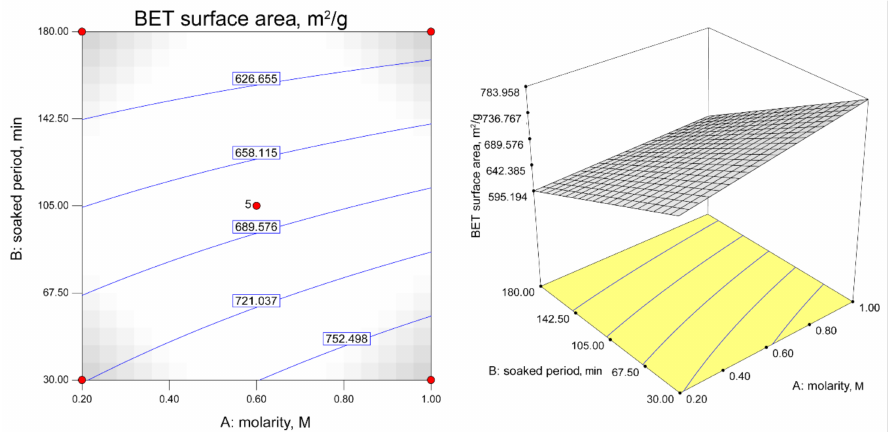
Figure 6. Contour plot describing the BET surface area response in soaked temperature function of molarity and soaked period (soaked temperature: 65 ◦